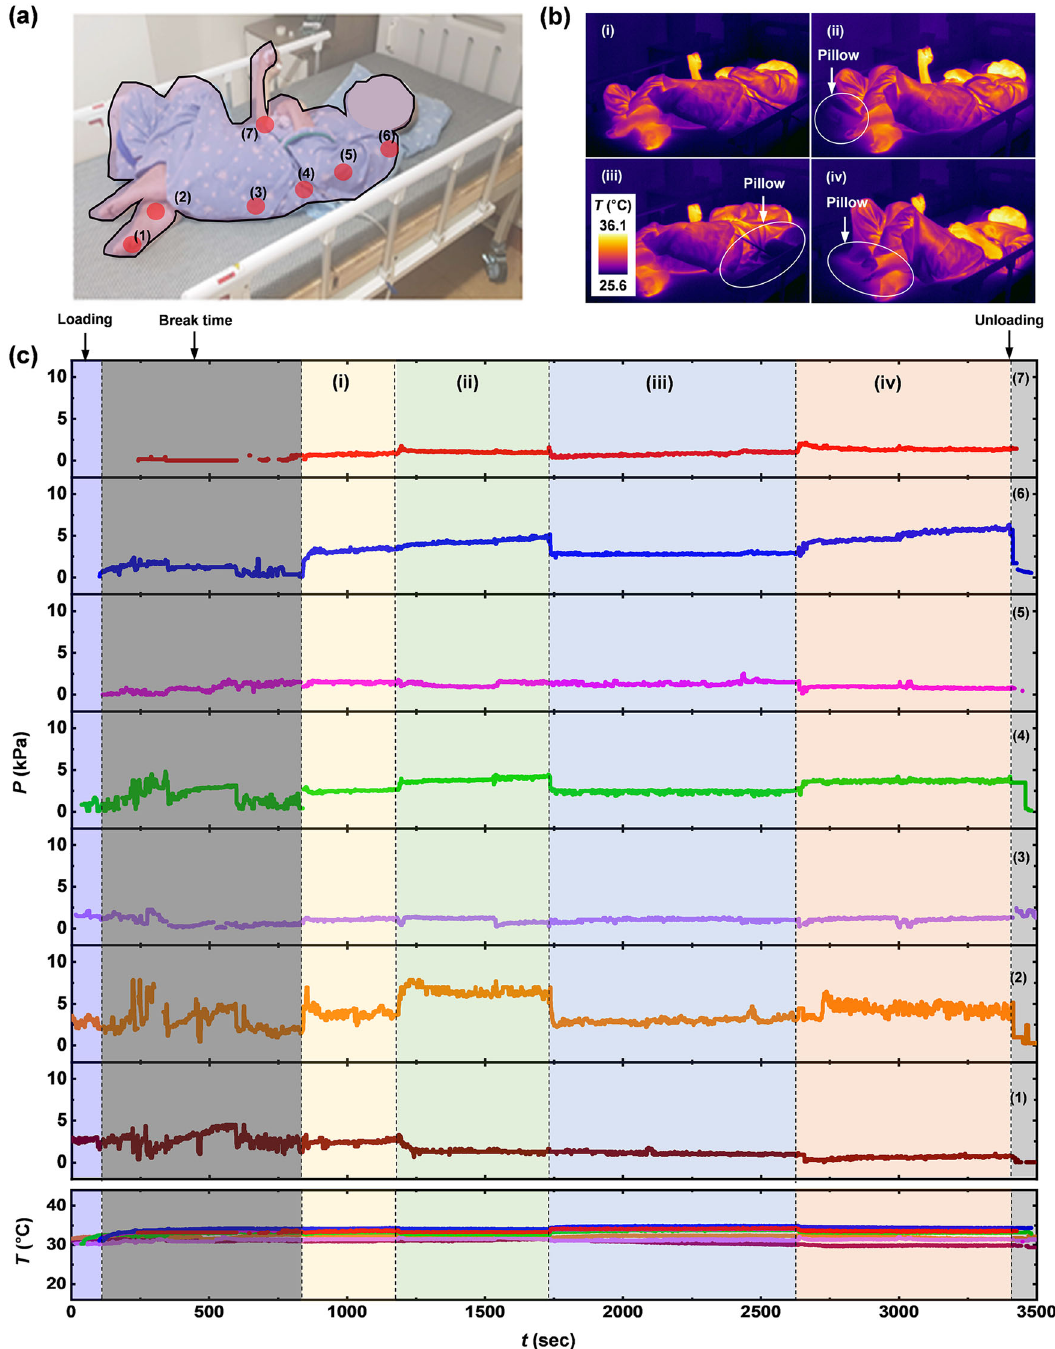
Fig. 8 Continuous measurements of pressure and temperature from a subject with general paralysis (83-year-old male, 40 kg, 150 cm) using the wireless-sensing platform. a Photograph of the subject with red discs to mark the mounting locations of the sensors. b IR images of changes in posture of the subject lying on bed with a pillow at different positions. c Results from continuous measurements of pressure and temperature from each of the